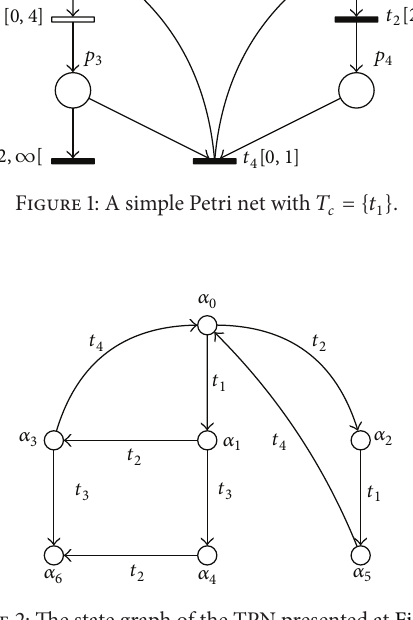
Figure 2: The state graph of the TPN presented at Figure